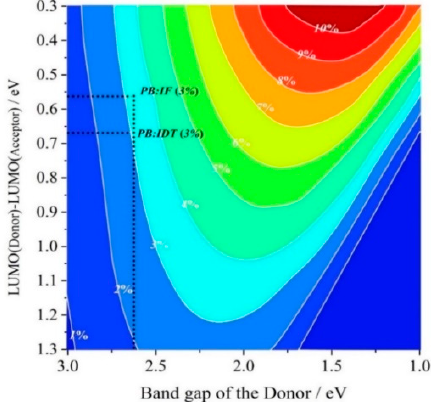
Figure 6. Predicted power conversion efficiency (PCE) for the PSCs PB:IF and PB:IDT with the Scharber diagram.